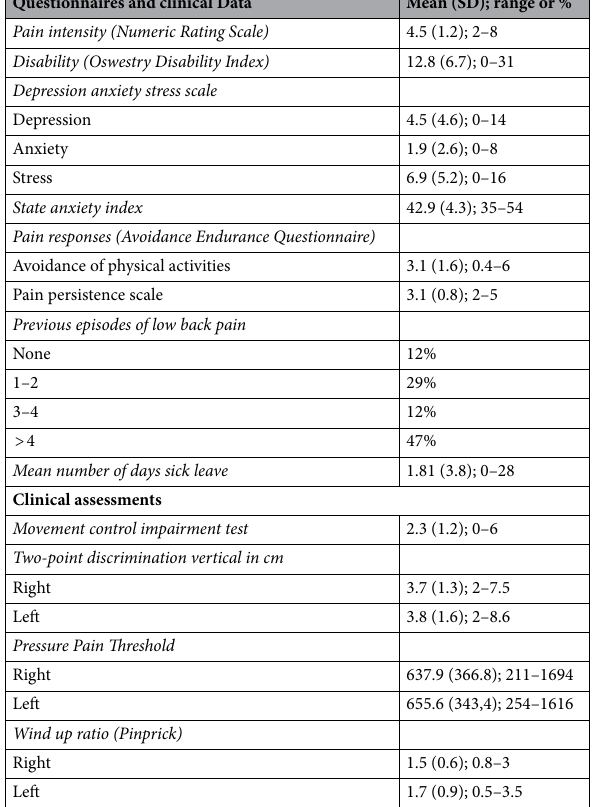
Table 1. Patients Baseline Characteristics (n =